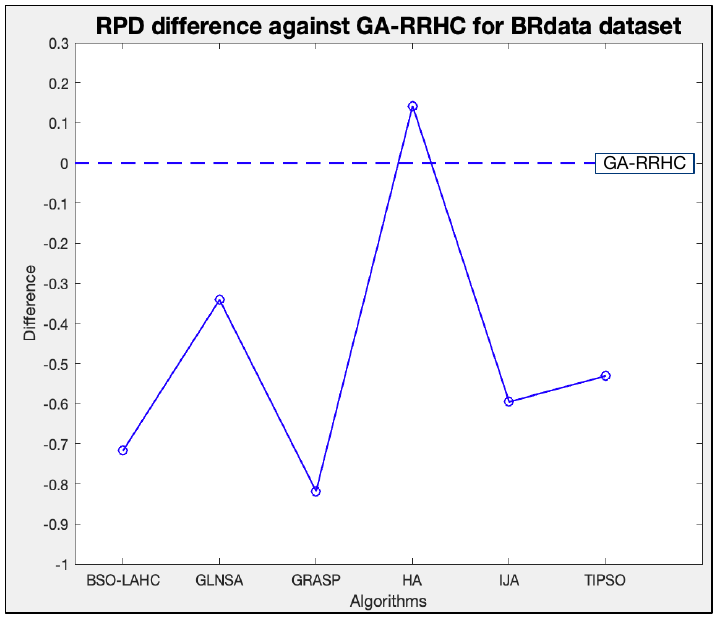
Figure 15. Comparison of the RPD difference per algorithm for the BRdata dataset.